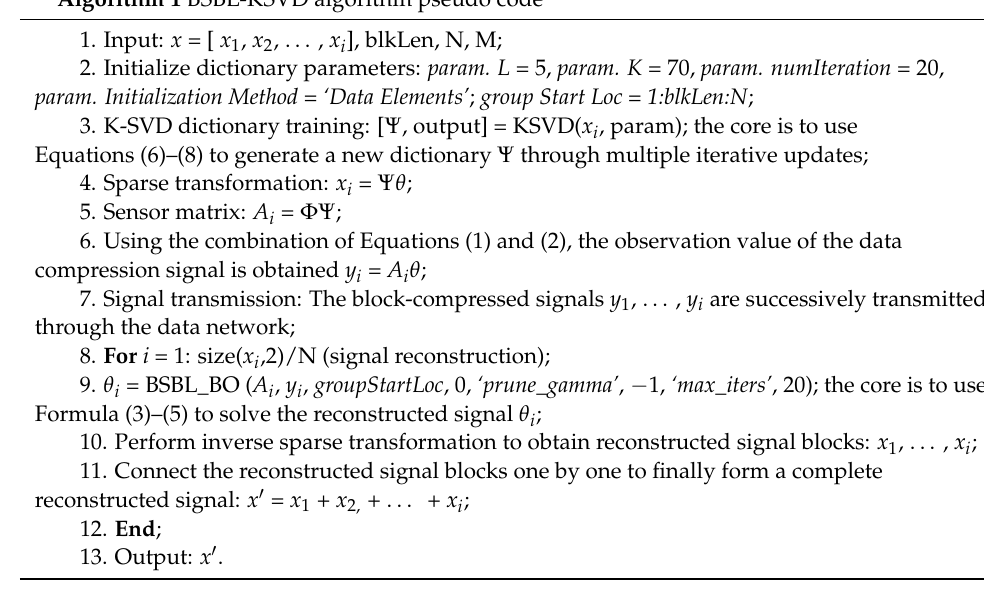
Algorithm 1 BSBL-KSVD algorithm pseudo